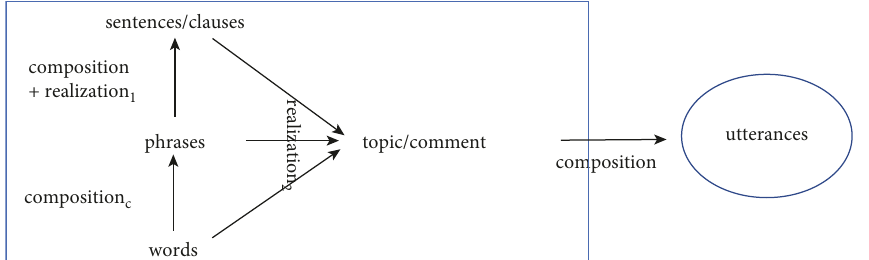
Figure 7: A refined compositionality of